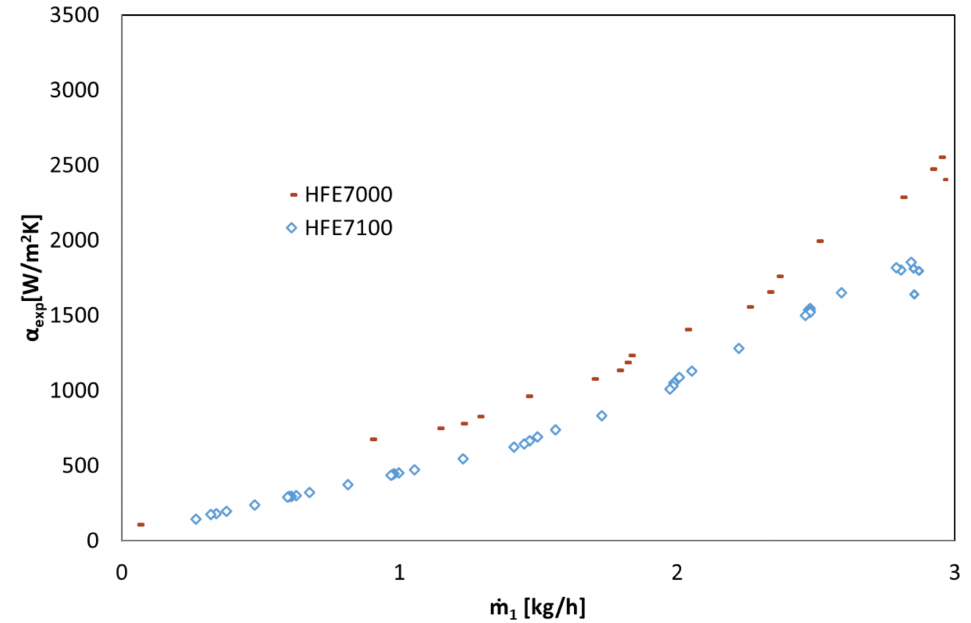
Figure 4. Results of experimental tests of thermal condensation of the refrigerants in the shell-and-tube exchanger, concerning the dependence of the heat transfer coefficient on the heat flux density, α exp = f(q), HFE 7100 and HFE 7000 refrigerants.